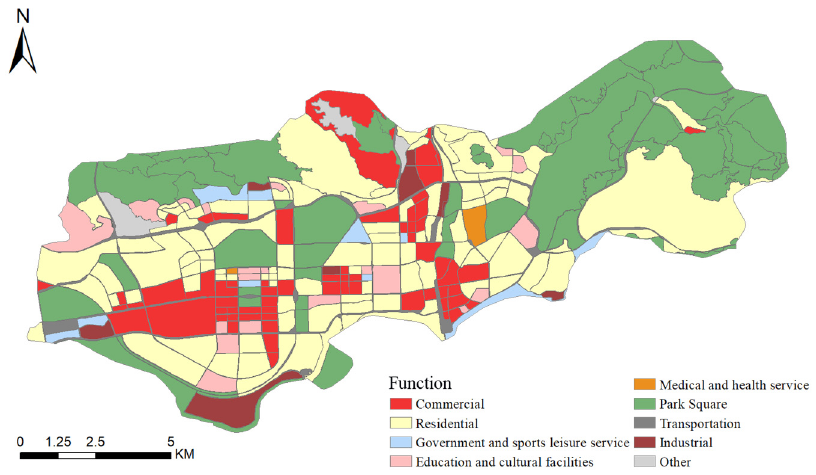
Figure 7. Dominant function partition of study area.